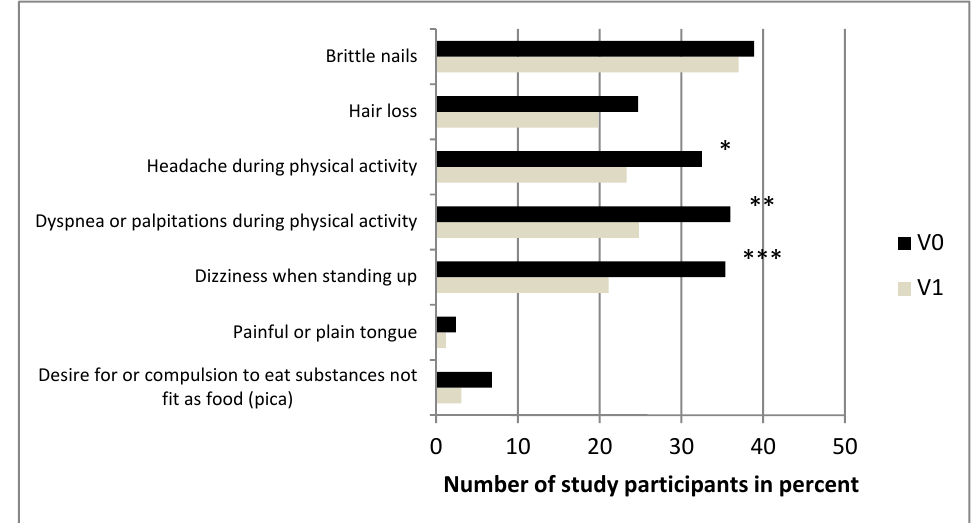
Figure 5. Bar diagram indicating the percentage of study participants on the x-axis with the appropriate symptoms indicated on the y-axis before (V0, dark bars) and after iron therapy (V1, bright bars). (* p = 0.02, ** p = 0.005, *** p < 0.001, n = 161–165).